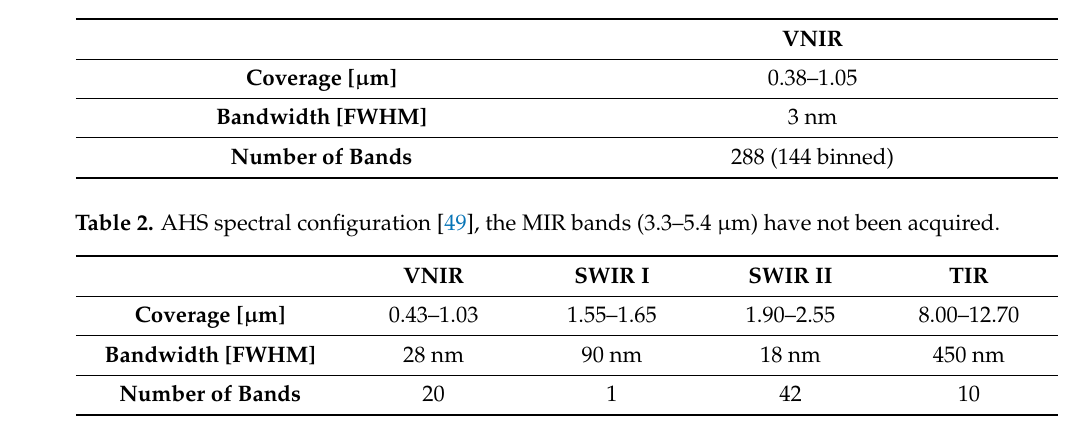
Table 1. CASI-1500i spectral configuration [48].